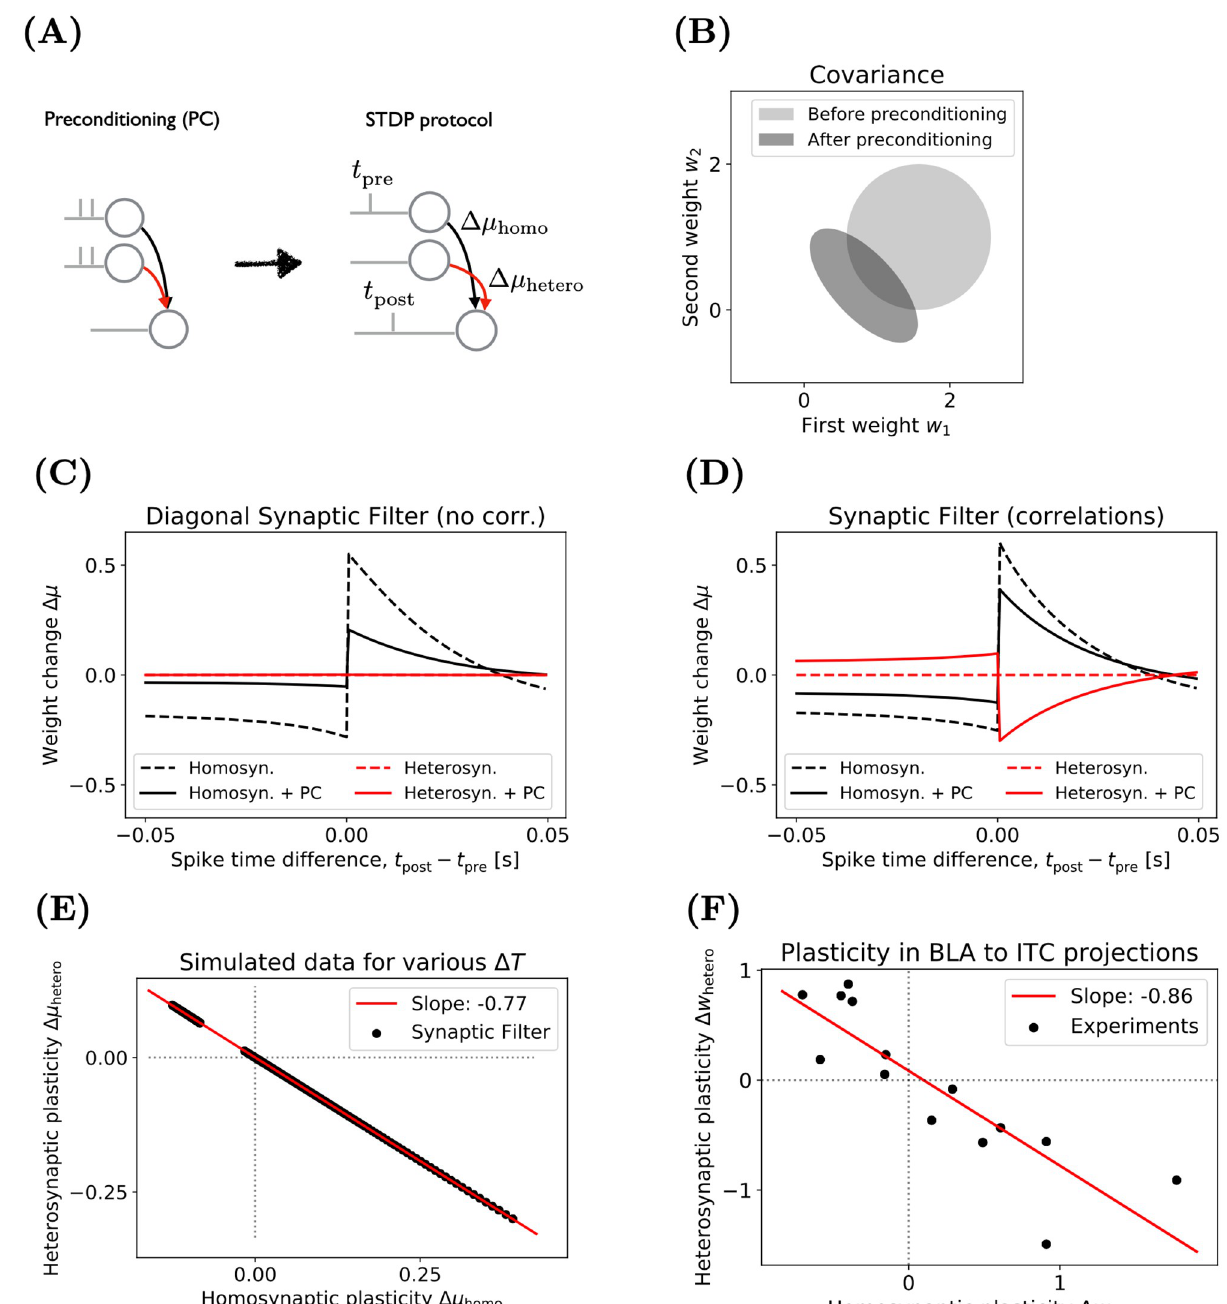
Fig 4. The Full Synaptic Filter explains experimentally observed anticorrelation of homo- and heterosynaptic plasticity. (A) Two inputs drive a neuron. During (optional) preconditioning (PC), two synchronous input spikes are delivered. Changes in the weights in the first and second weight in response to an STDP protocol are reported as homosynaptic (black) and heterosynaptic (red) plasticity respectively. See Section 4.4 in Materials and methods for more details. (B) The effect of PC on the equilibrium weight distribution, visualised by contours, of the Full Synaptic Filter (light grey). After PC, the weight distribution (dark grey) has lower mean and weights become anticorrelated. (C) The Diagonal Full Synaptic Filter exhibits homosynaptic STDP (black lines) but no heterosynaptic plasticity (red lines). PC reduces plasticity (solid black line). (D) The Full Synaptic Filter exhibits homo- and heterosynaptic plasticity (solid black and red lines) after PC. Without PC (dashed lines), the Full Synaptic Filter behaves like its diagonal counterpart shown in C . (E) The Full Synaptic Filter predicts that homo- and heterosynaptic plasticity are anticorrelated. The x - and y - locations of the black points correspond to the solid black and red lines in (C) . (F) Anticorrelated homo- and heterosynaptic plasticity was found in synaptic projections from BLA to ITC neurons, Figure redrawn from [51].